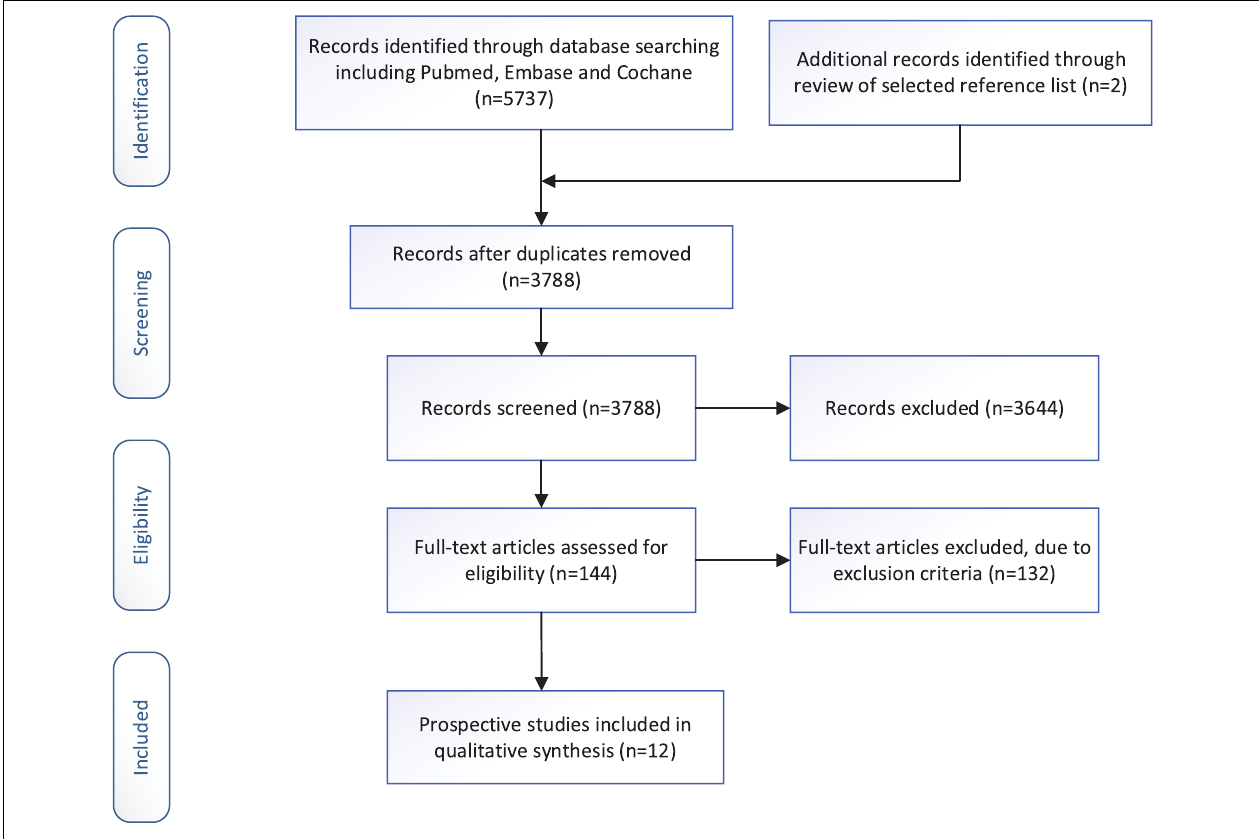
FIGURE 1 | Literature search flow